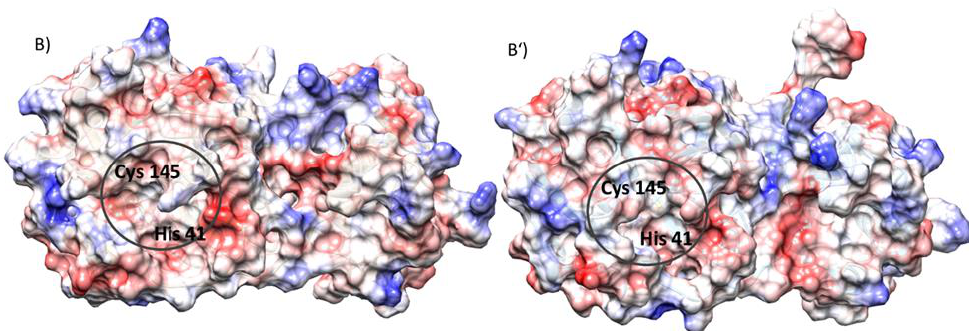
Figure 1. ( A ) Alignment of the most representative structure of the SARS-CoV-2 M pro -HID (cyan) and SARS-CoV-2 M pro - HIE (gold), as obtained from a cluster analysis along the molecular dynamics trajectories. The insets evidence the structural organization inside the catalytic dyad (His41-Cys145). ( B ) and ( B’ ) Electrostatic potential surface (APBS) in the SARS-CoV- 2 M pro -HID ( B ) and SARS-CoV-2 M pro HIE ( B’ ).